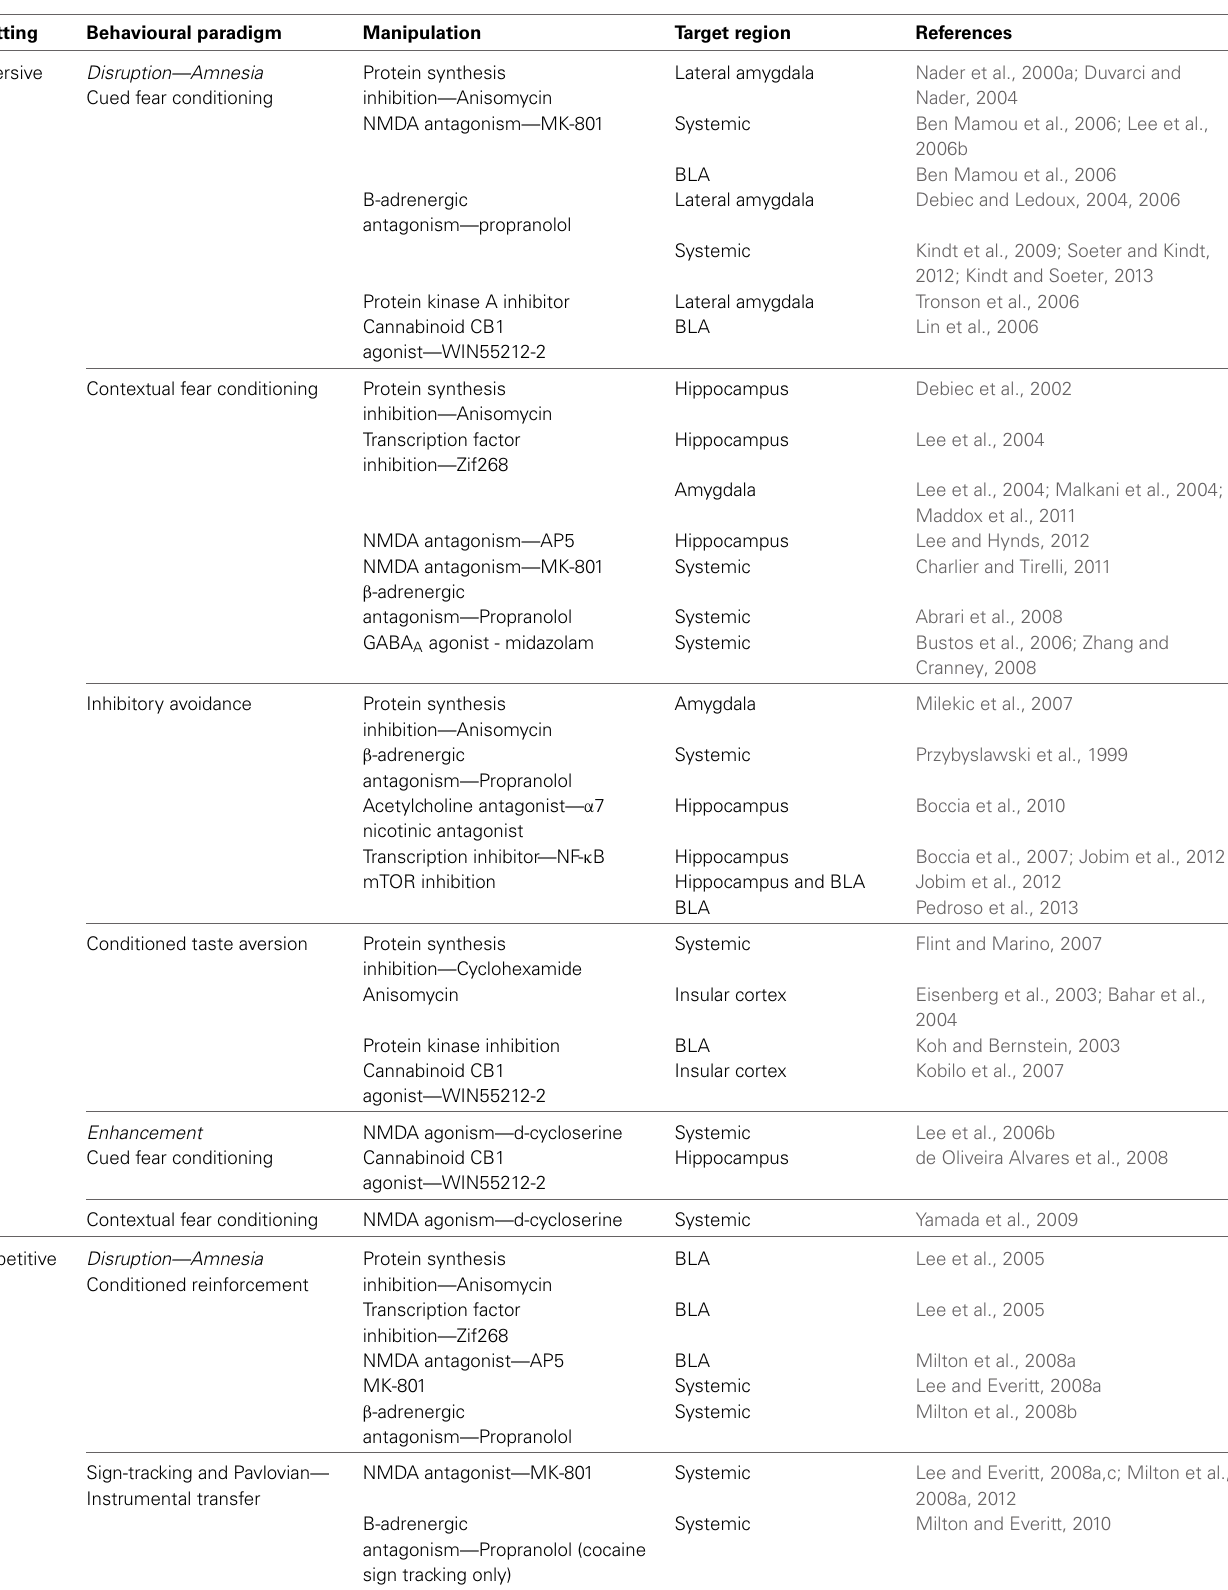
Table 1 | Summary of aversive and appetitive paradigms including details of target structures and mechanisms.